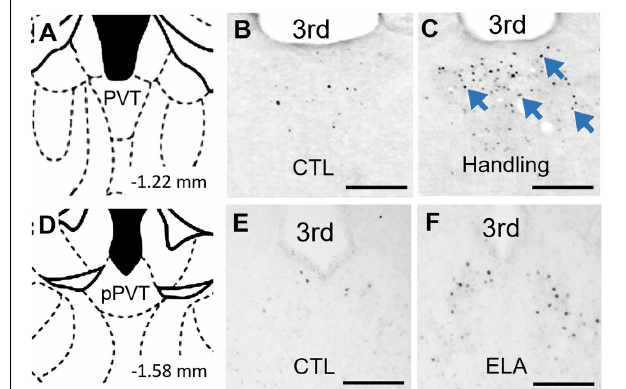
FIGURE 2 | PVT neurons are activated by early life experiences. (A) Level of mid PVT indicated by brain atlas (Paxinos and Watson, 2005). (B) In P9 rats that were reared in control conditions through P2-9, little activation of PVT was found on P9. (C) In contrast, abundant neuronal activation in PVT (blue arrows) was observed 30 min after receiving augmented maternal care in P9 in rats handled from P2-9 (Handling). Adapted from Fenoglio et al. (2006) with permission. (D) Level of posterior PVT indicated by brain atlas. (E) Little activation of PVT was observed in P9 mice reared in control conditions through P9. (F) In contrast, abundant neuronal activation in PVT was observed on the morning of P9 in mice reared in ELA conditions beginning on P2. 3rd, third ventricle. Scale bars, 500